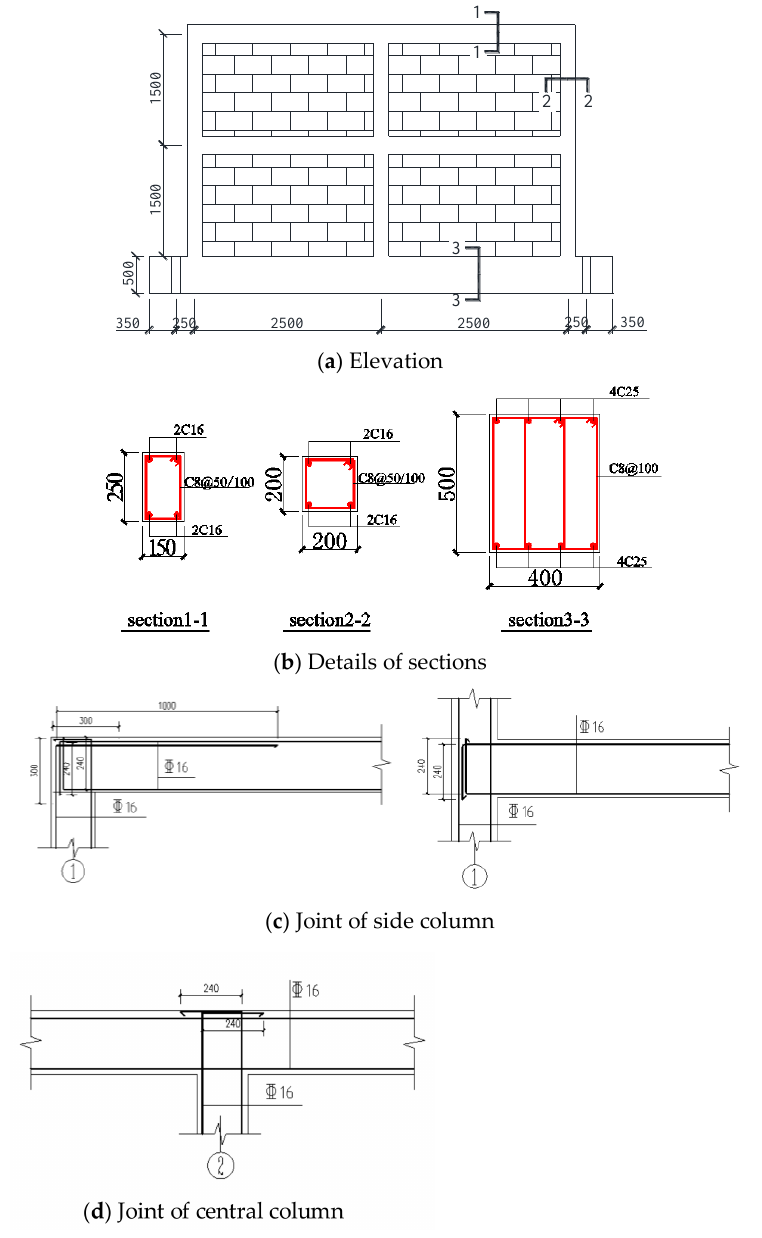
Figure 1. Geometry and reinforcement details of specimens. The main parameters of the test are whether to build infill walls and the different types of infill walls. The basic information of the test specimen is shown in Table 1. Specimen FS-1 was an empty frame as the control specimen, while FS-2 and FS-3 were built with clay air bricks and aerated lightweight concrete blocks (ALC), respectively. Before building the infill walls, two HPB300 MPa tie rebars with the diameter of 6 mm were set along the frame column every 500 mm to ensure the effective tie between the concrete frame structure and the infill walls and the out-of-plane stability of the infill walls, and the length of the tie rebar was 700 mm [37]. The tie bars were chemically anchored to the frame column with planting glue, and the anchorage depth is 70 mm. The infill walls were constructed by the method of staggered joints. Figure 2 shows the actual effect of the specimens after the completion of the construction of the infill